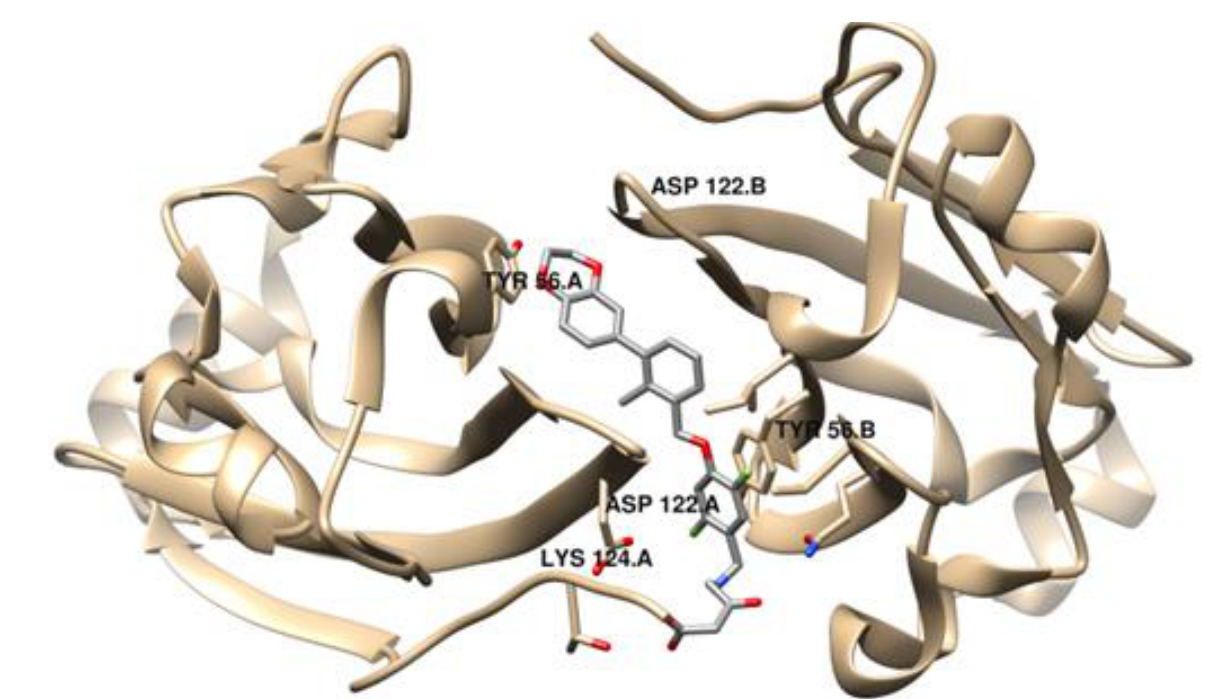
Figure 4. Visualization of the co-crystal dimer structure of PD-L1 in complex with BMS-200 (Protein Data Bank, PDB ID: 5N2F), highlighted with the critical residues for ligand binding, using UCSF Chimera [57,58].